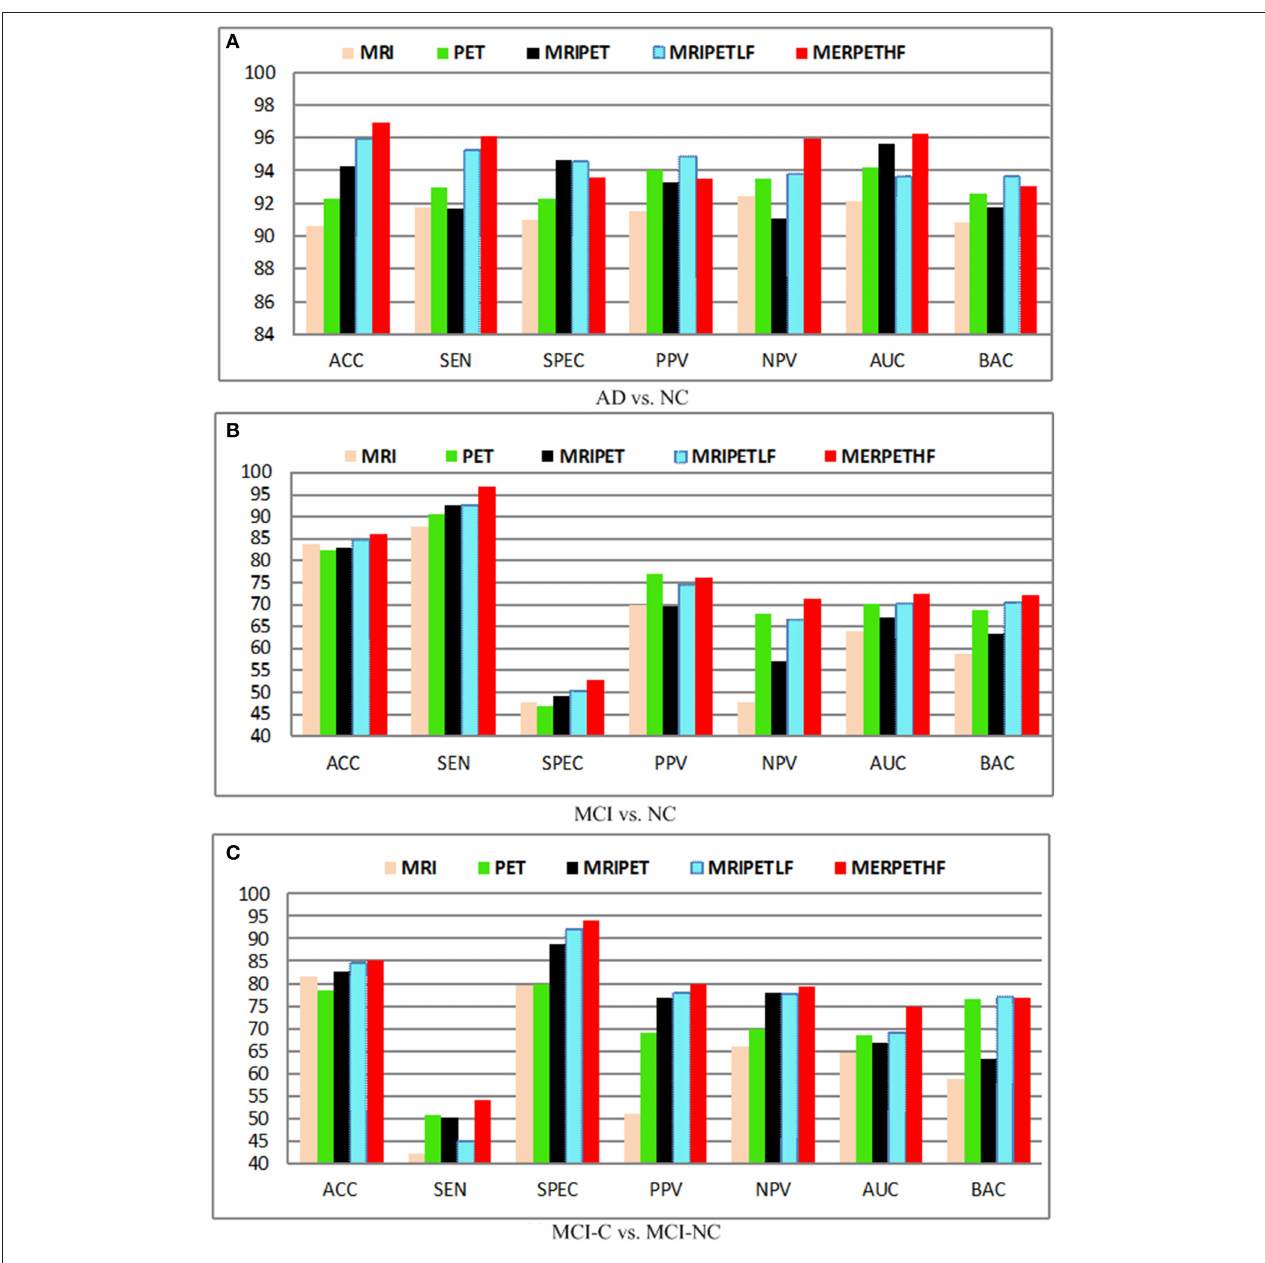
FIGURE 6 | Diagnosis results with different modalities. (A) AD vs. NC; (B) MCI vs. NC; (C) MCI-C vs.